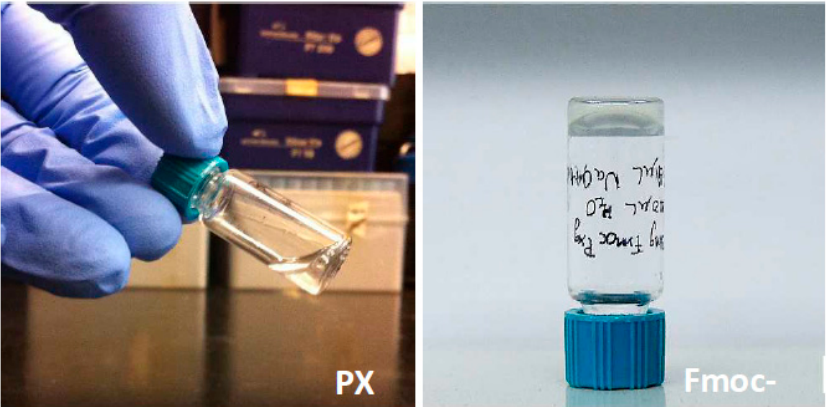
Figure 1. Self-assembly of Fmoc-Pexiganan (Fmoc-PXG) leads to a self-standing translucent hydrogel ( right ), whereas PXG under the same conditions results in no macroscopic signs of self-assembly and gel formation ( left ).